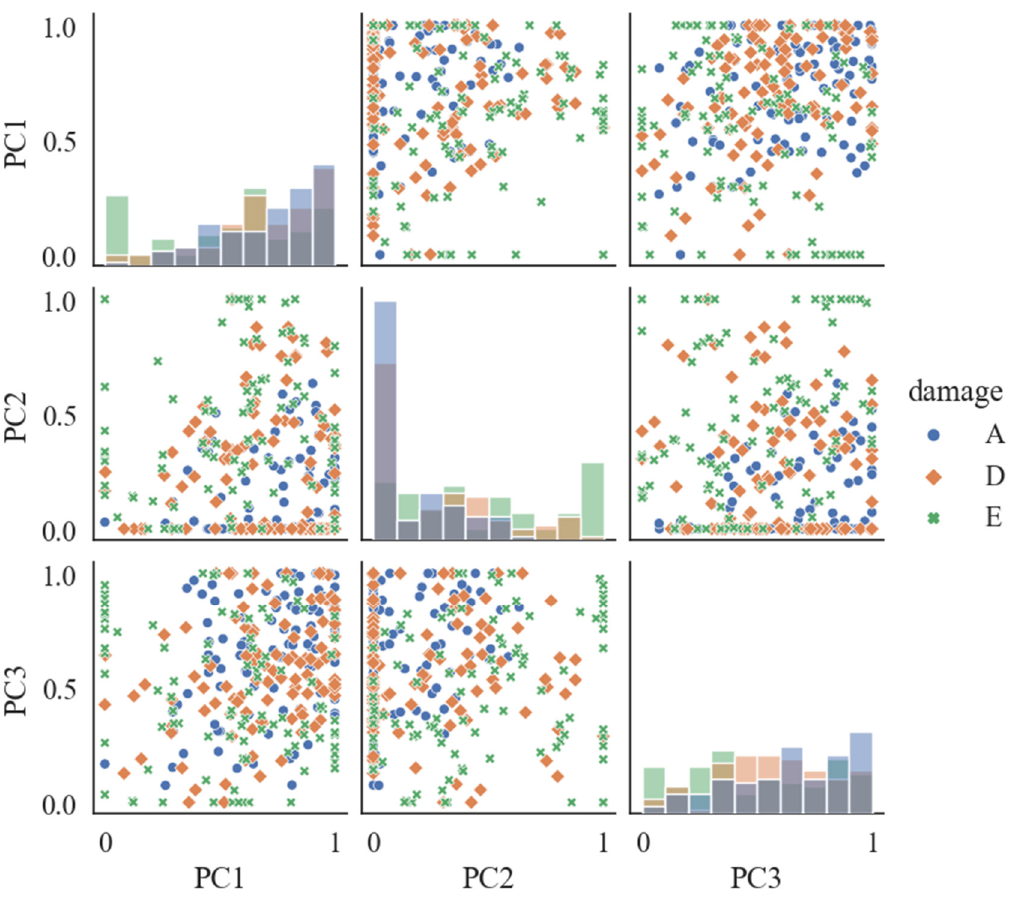
Figure 9. Distribution patterns of the PCA-based features.